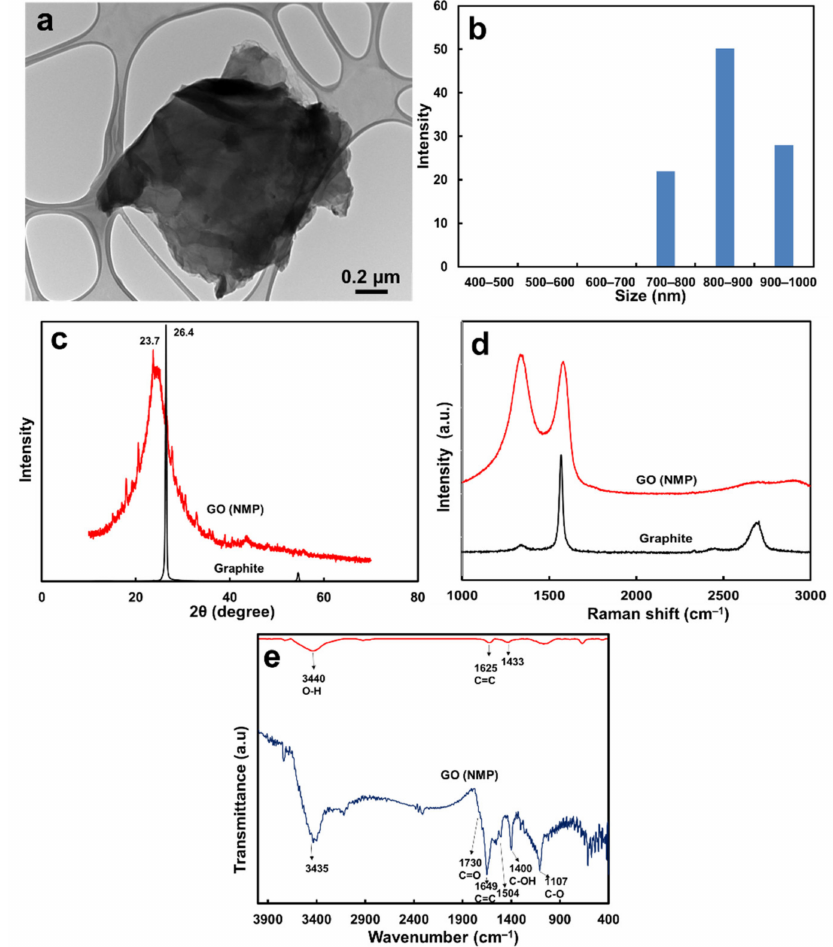
Figure 1. ( a ) TEM micrograph and ( b ) particle size distribution of GO in NMP solution, ( c ) XRD patterns, ( d ) Raman spectra, and ( e ) FTIR spectra of commercial graphite and GO prepared from NMP